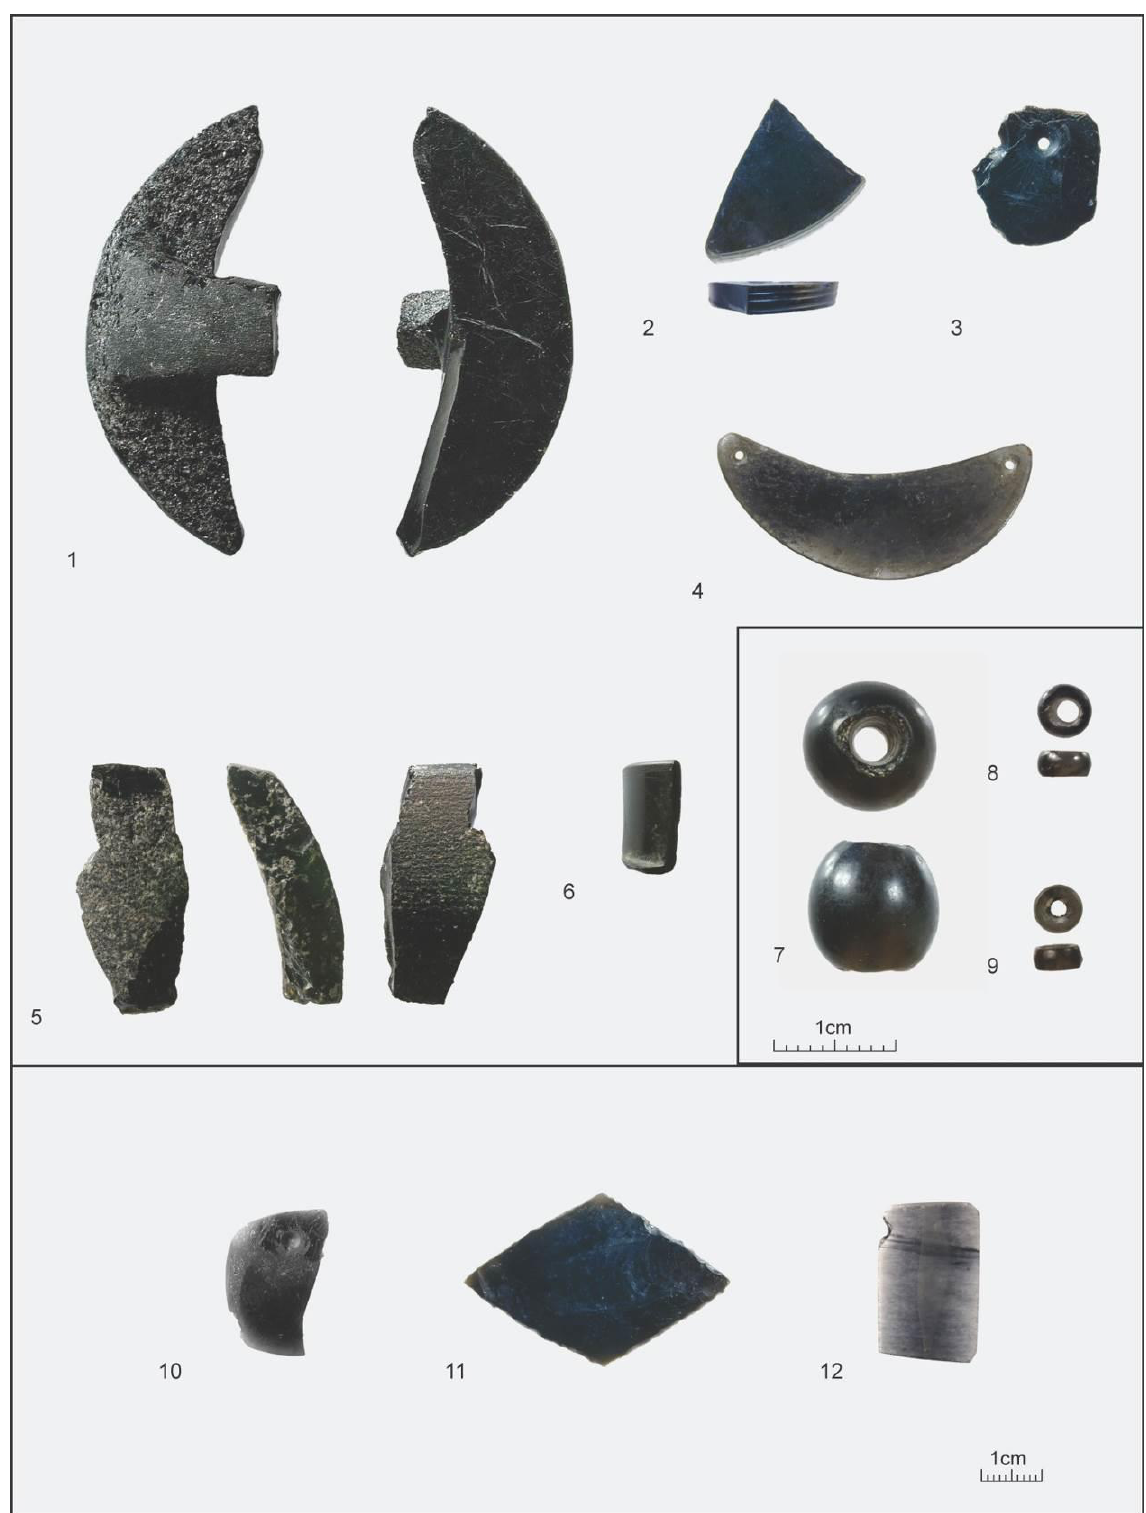
Figure 3. A selection of ground and polished objects from Domuztepe: 1. Mirror with strap handle, dt3494; 2. Highly polished disc or mirror with concentric grooves around the edges, dt427; 3 Pendant, dt2141, with minimal grinding and break on perforation; 4 Crescentic link, dt1069; 5. Vessel fragment, dt2625, pecked and ground but not polished; 6. Rim fragment of highly polished vessel, dt275; 7-9. Beads, dt1107, dt2832 and dt2227; 10-12: Unfinished obsidian items, dt6973, dt354 and dt7164 (photographs by Stuart